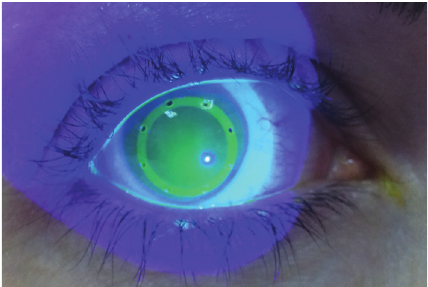
Figure 2: High molecular-weight fluorescein accumulation. Saline stained with high molecular weight fluorescein was applied on the Therapeutic Hyper-CL ™ surface while on the patient eye. The high molecular weight fluorescein does not penetrate the lens matrix; thus, a high fluoresce pattern demonstrates the accumulation of 5% salt solution or any other therapeutic eye drops under the lens. This fluorescing pattern was shown to last on the eye for 10–20